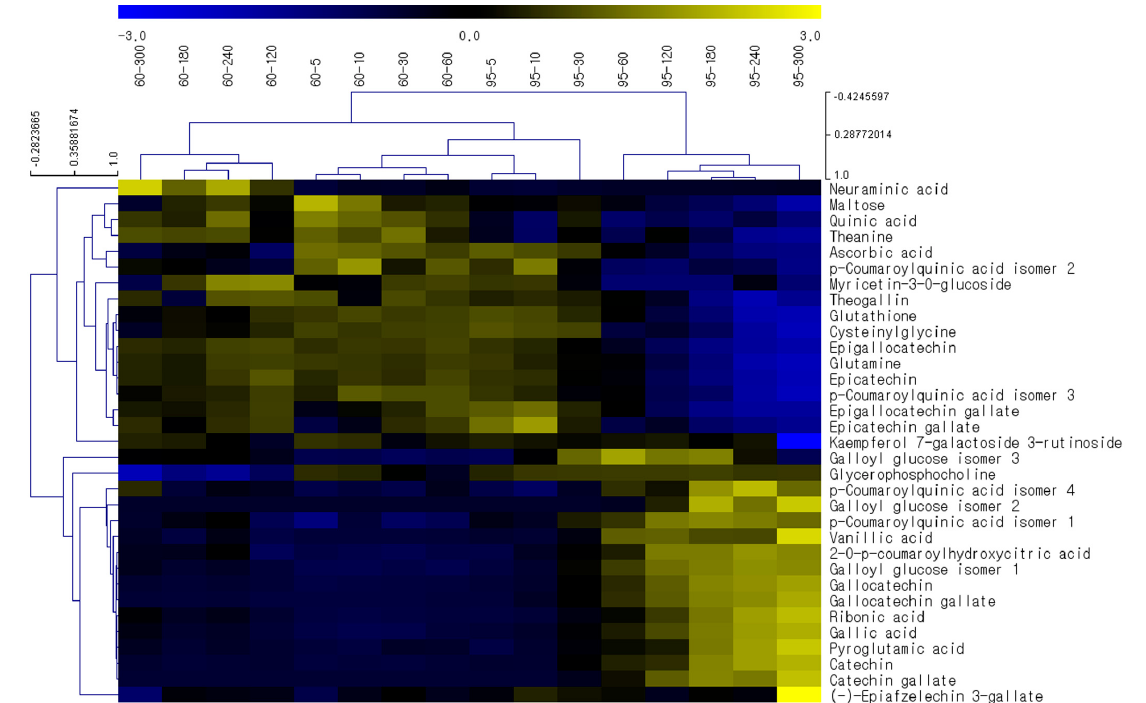
Figure 2. Hierarchical clustering and heat map of 33 differential marker compounds.